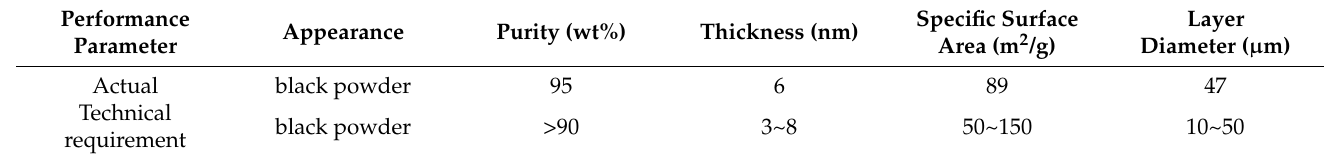
Table 7. Technical specifications of graphene.